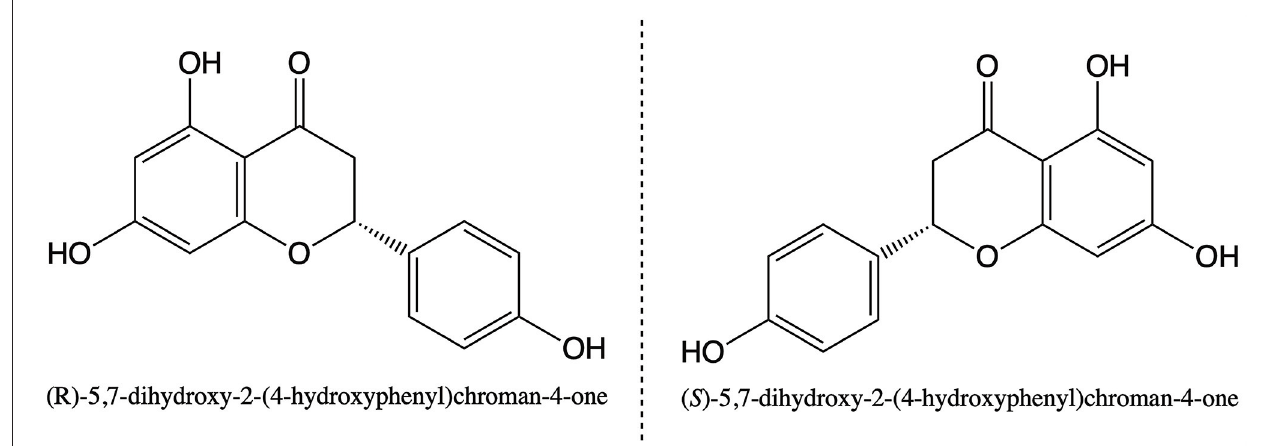
FIGURE 1 | Chemical structures of naringenin